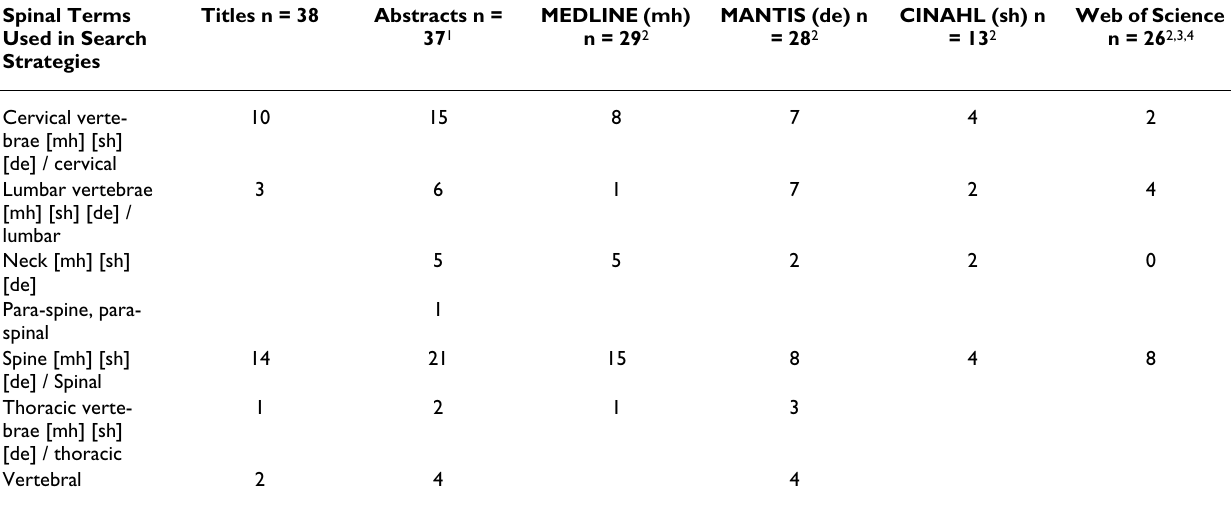
Table 3: Frequency of spinal terms in titles, abstracts, and four databases Spinal Terms Used in Search Strategies